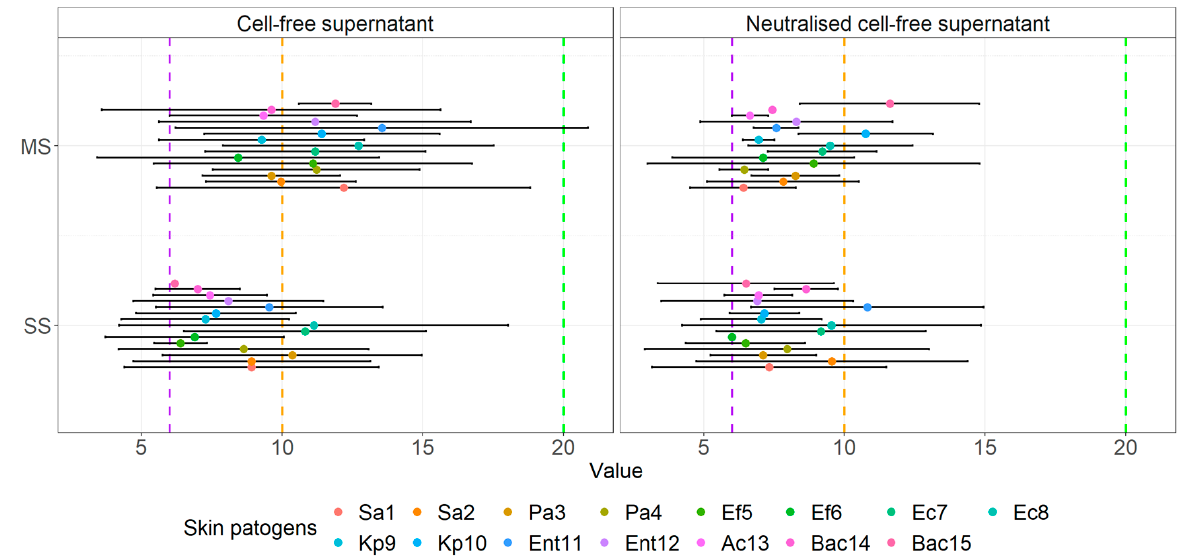
Figure 6. Means of the inhibition zone together with 95% CI of cell-free supernatants of multi-strain and single-strain probiotics against clinical skin pathogens using the agar well diffusion assay. Statistically comparing results of the inhibition of cell-free supernatant and neutral- ized cell-free supernatants agar well diffusion, S and NS respectfully (Figure 6), with the aforementioned groups we observed, that there was no statistically significant interaction between agar well diffusion results and all probiotics of beneficial microbes (F(17.504) = 1.281, p = 0.199), but there was a simple main effect on various probiotics ( p < 0.001) and agar well diffusion ( p < 0.001) on the mean zone.